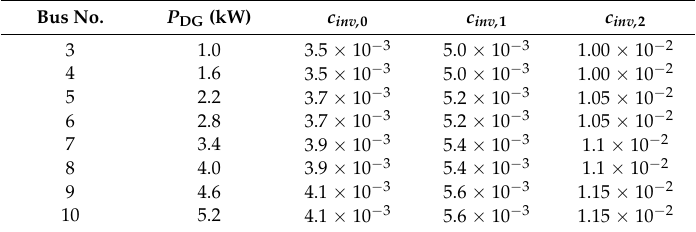
Table 2. Constant impedance-current-power (ZIP) model parameters.